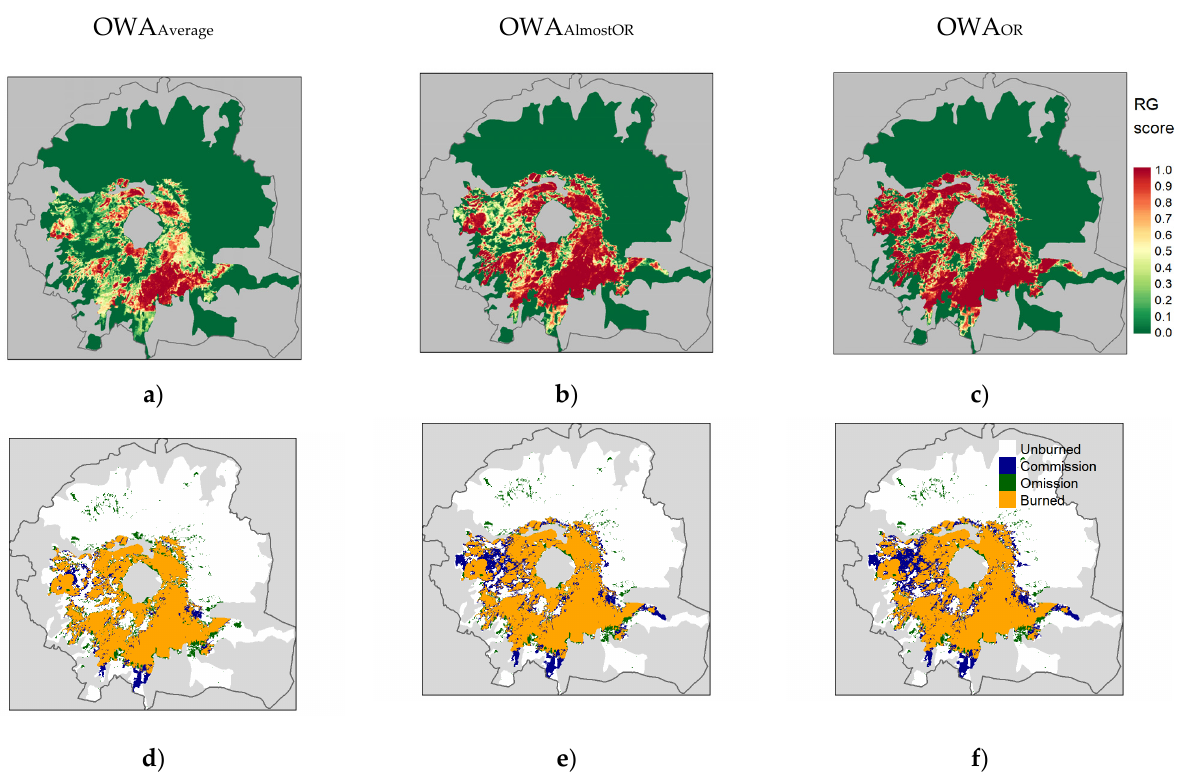
Figure 8. RG score and agreement maps for the Vesuvius training site for growing layers OWA Average ( a , d ), OWA AlmostOR ( b , e ) and OWA OR ( c , f ).